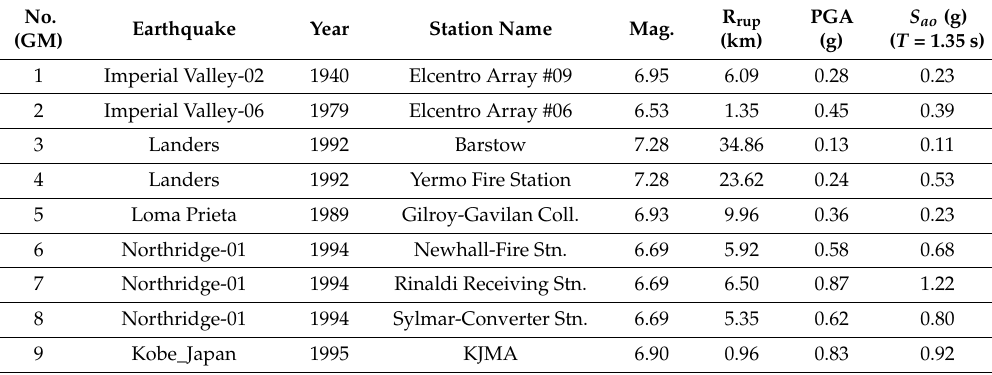
Table 2. Unscaled ground motions and spectral